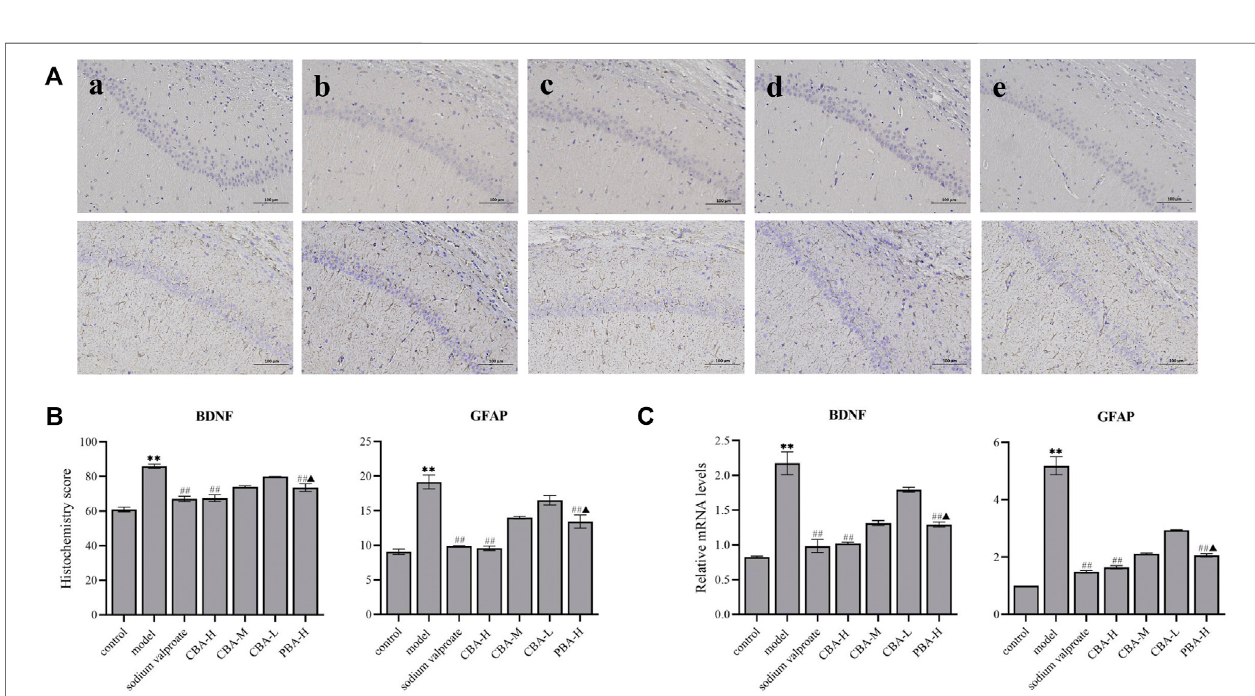
FIGURE 7 | CBA inhibited the expression of BDNF and GFAP in the hippocampus of FS rats. (A) Immunohistochemical staining exhibiting the hippocampal expression levels of BDNF and GFAP. Original magni fi cation ×200: (a) control; (b) model; (c) FS + sodium valproate; (d) FS + CBA-H (2.8 g/kg); and (e) FS + PBA (2.8 g/kg) groups. (B) The semi-quantitative analysis of the protein expression of BDNF and GFAP in the hippocampus. (C) The mRNA expression level of BDNF and GFAPwereanalyzedviaqRT-PCR.DataofthehistochemistryscoreandmRNAexpressionswereexhibitedasthemean±SEM.** p < 0.01comparedtothatofthe control group; ## p < 0.01 compared to that of the model group; ▲ p < 0.05 compared to that of the CBA-H group.